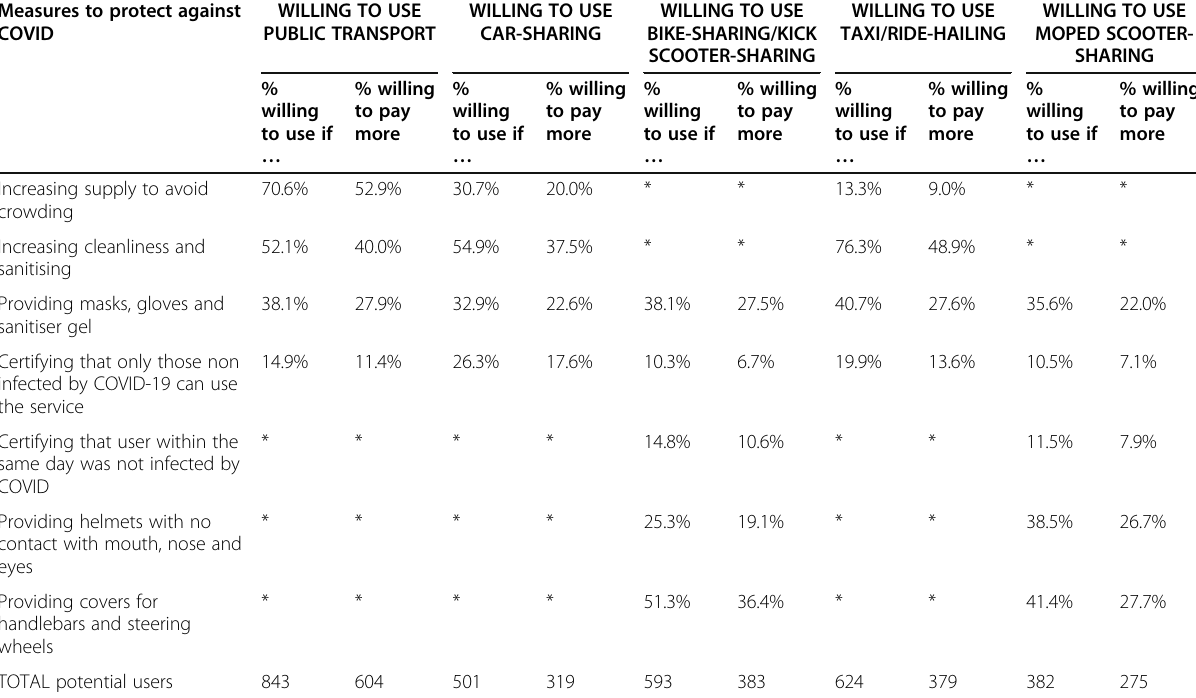
Table 3 Potential users ’ willingness to use specific transport modes and potential measures to protect against COVID-19 Measures to protect against